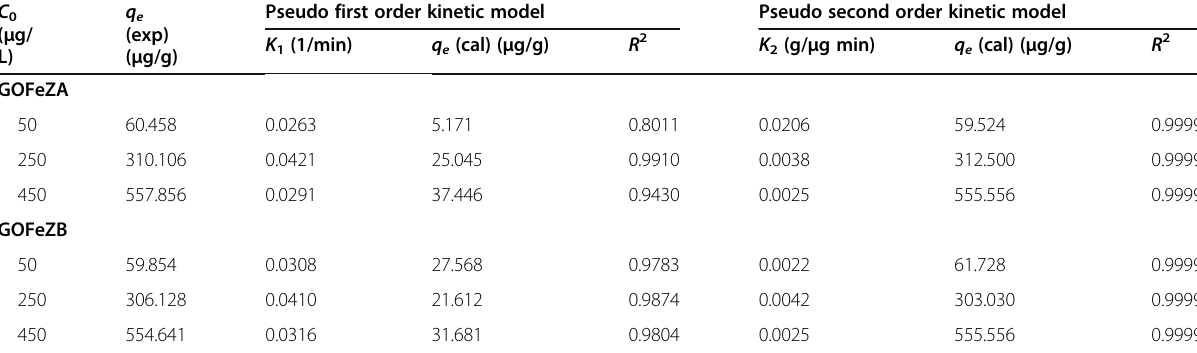
Table 2 The parameters of pseudo first order and second order kinetic model for arsenate adsorption on GOFeZA and GOFeZB C 0 ( μ g/